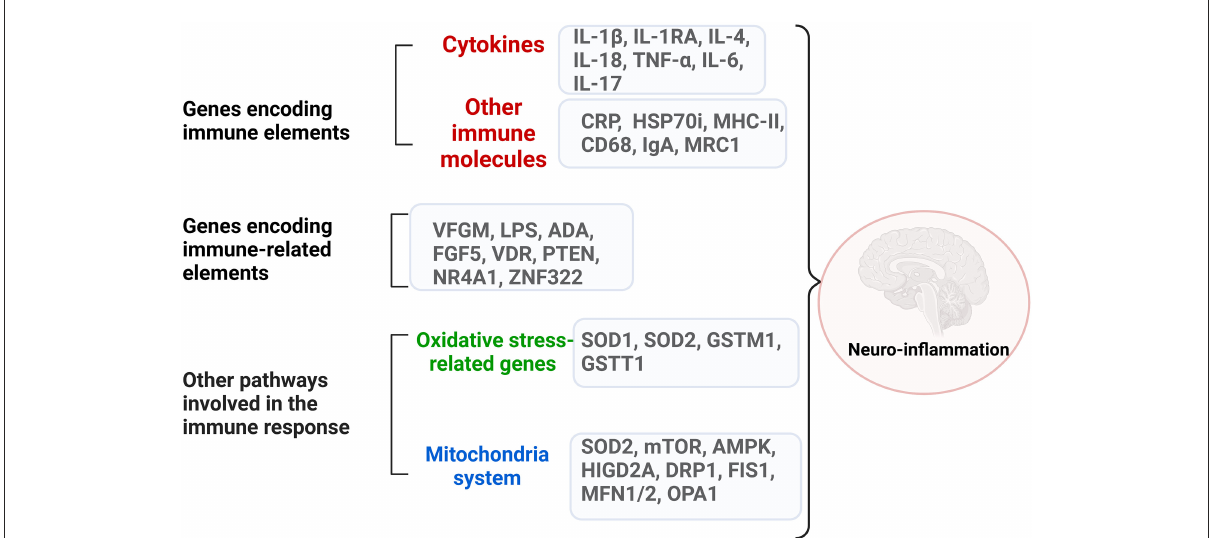
FIGURE2 The complex network of dysregulated genes encoding immune system elements and immune-related ones in ASD. Neuroinflammation can be generated through dysregulated genes from three categories: genes that encode directly immune molecules, like cytokines and surface molecules on the immune cells; genes that encode elements involved in major immune pathways like growth factors, proliferation processes; genes that encode molecules involved in oxidative stress and mitochondria pathways. Created with BioRender.com.